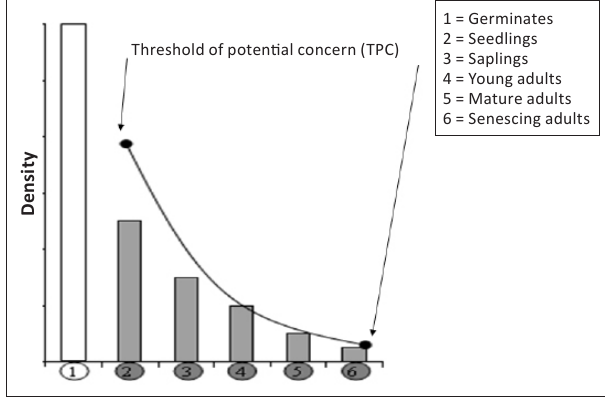
FIGURE 5: The negative J-shaped population structure for all non-germinant, established individuals of Breonadia salicina , used for auditing of thresholds of potential